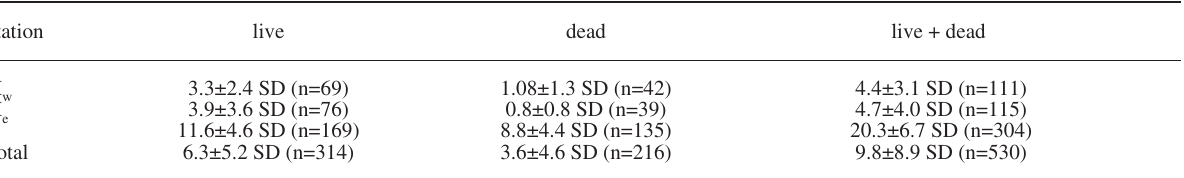
Table 2. − densities (ind. /m 2 ) of live, dead and overall specimens of P. nobilis in each station.